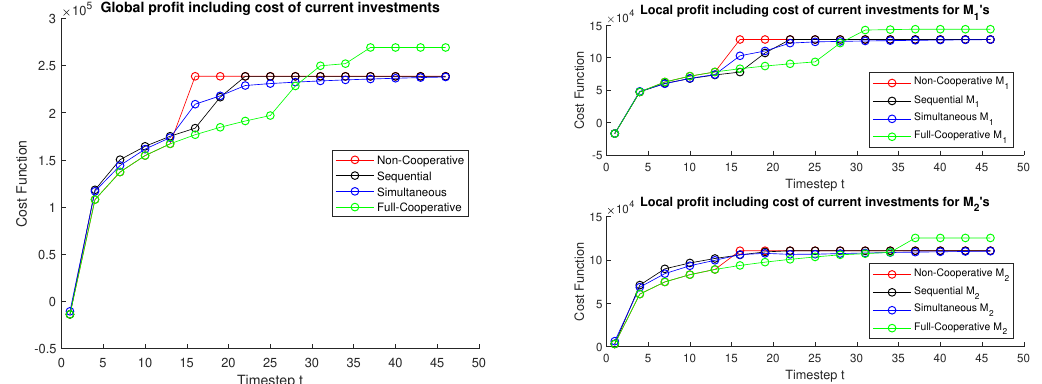
Figure 7. Global and local profit of supplier development of all